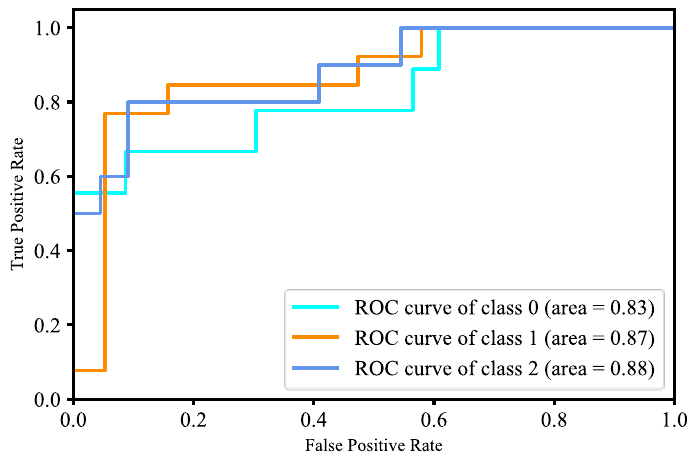
Figure 40. ROC curve of human face detection.